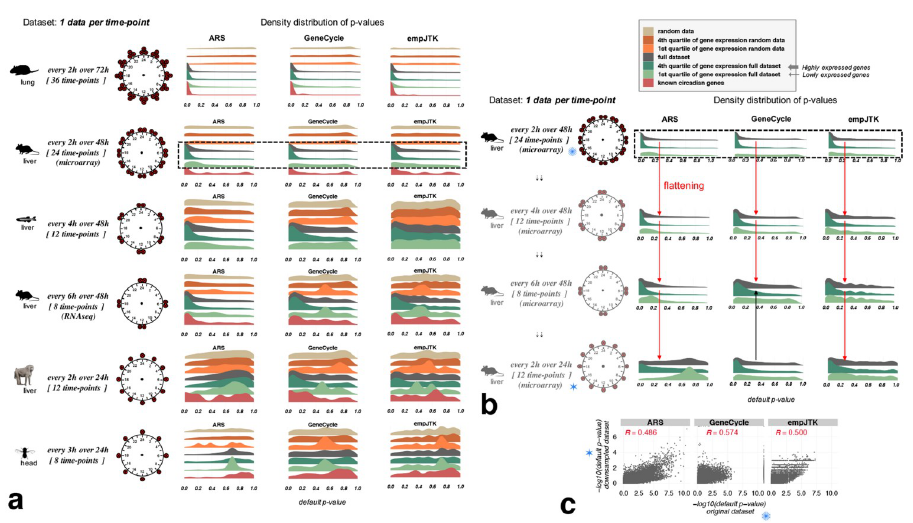
Fig 3. Datasets with one replicate per time-point over a unique cycle of 24 hours do not provide enough information to detect rhythmicity. Methods lose in statistical power for detecting rhythmic patterns in gene expression when the number of 24h cycles decreases, or when the number of time-points sampled decreases. a) Default p -value distributions obtained for ARS, GeneCycle, and empJTK applied to different datasets and sub-categorized in: i. randomized data which represents the null hypothesis; ii. randomized data restricted to the first and fourth quartiles of the median gene expression level, to check for the impact of expression level under the null; iii. the full original dataset; iv. the first and fourth quartiles of the median gene expression level of the original data; and v. a subset of known cycling genes (8 to 99 genes according to species, see Methods). For each dataset, the number of time-points with data and the temporal resolution is illustrated around a 24h clock. For the same number of time-points, performance seems better with two cycles than only one cycle (zebrafish vs baboon). b) The reduction of the number of time-points of the mouse liver microarray dataset shows increasingly weak rhythm detection by ARS, GeneCycle, and empJTK, shown by a flattening of the p -value distribution on the full dataset (red arrow). GeneCycle showed no difference between a few time-points over two cycles or more time-points over a single cycle (black arrow). c) Scatter-plots of p -values obtained before and after down-sampling (every 2h over 48h vs. every 2h over 24h) for the full dataset. Each point is a gene. R is the Pearson correlation; p -value < 2.2e–16 in all cases. After down-sampling, the rhythmic signal is retrieved for the same genes. Images credit: Anthony Caravaggi (mouse), Ian Quigley (zebrafish), wikipedia GNU GPL Muhammad Mahdi Karim (baboon), and Public Domain for other images (from PhyloPic).